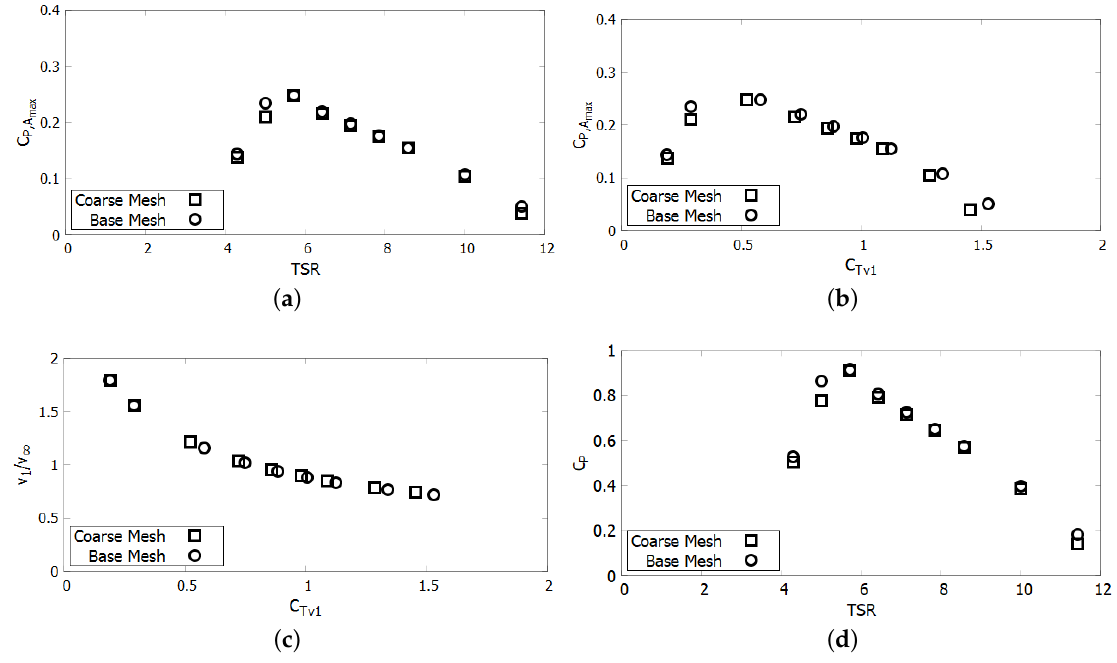
Figure 6. Ducted results. ( a ) C P , A